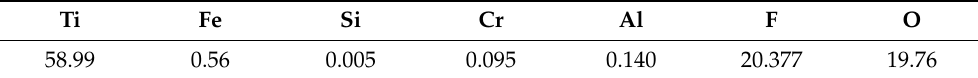
Table 1. Content of controlled components in titanium fluorides, wt%.